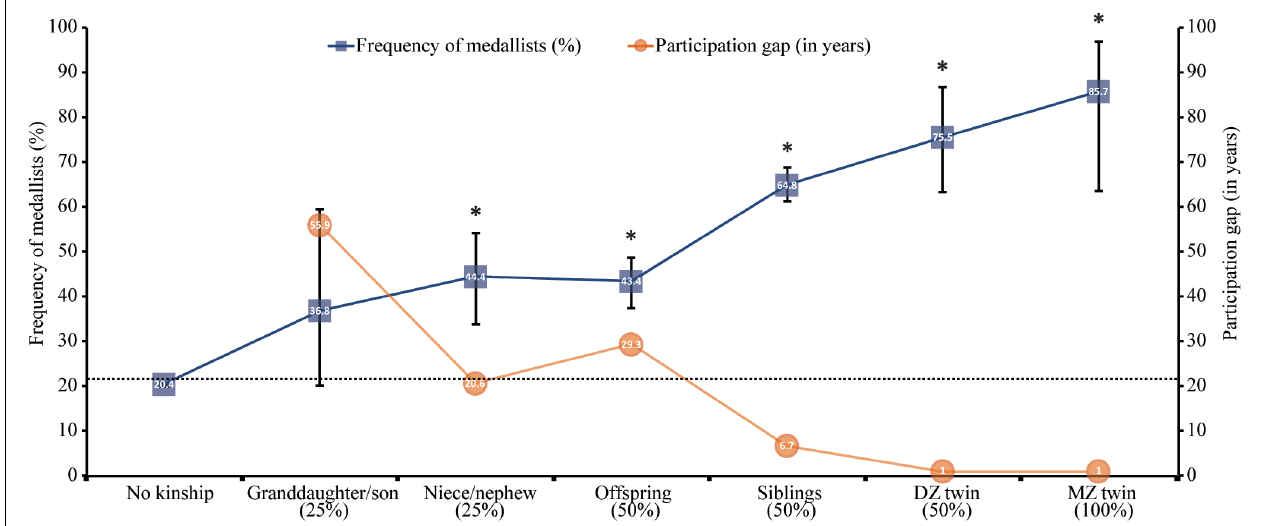
FIGURE 3 | Frequencies (%) ( ± 95% CI) of Olympic Medallists (blue squares) according to an average gradient of relatedness (x-axis labels %) with former Medallists in the Olympic Games. Participation gap (orange circles) represents the mean of years separating the first participation in the Olympics between each pair of kinship. The dotted vertical line shows the average prevalence of medals in the history of the Olympic Games. ∗ The Medallist frequency is significantly different ( p < 0.001) from the expected one.